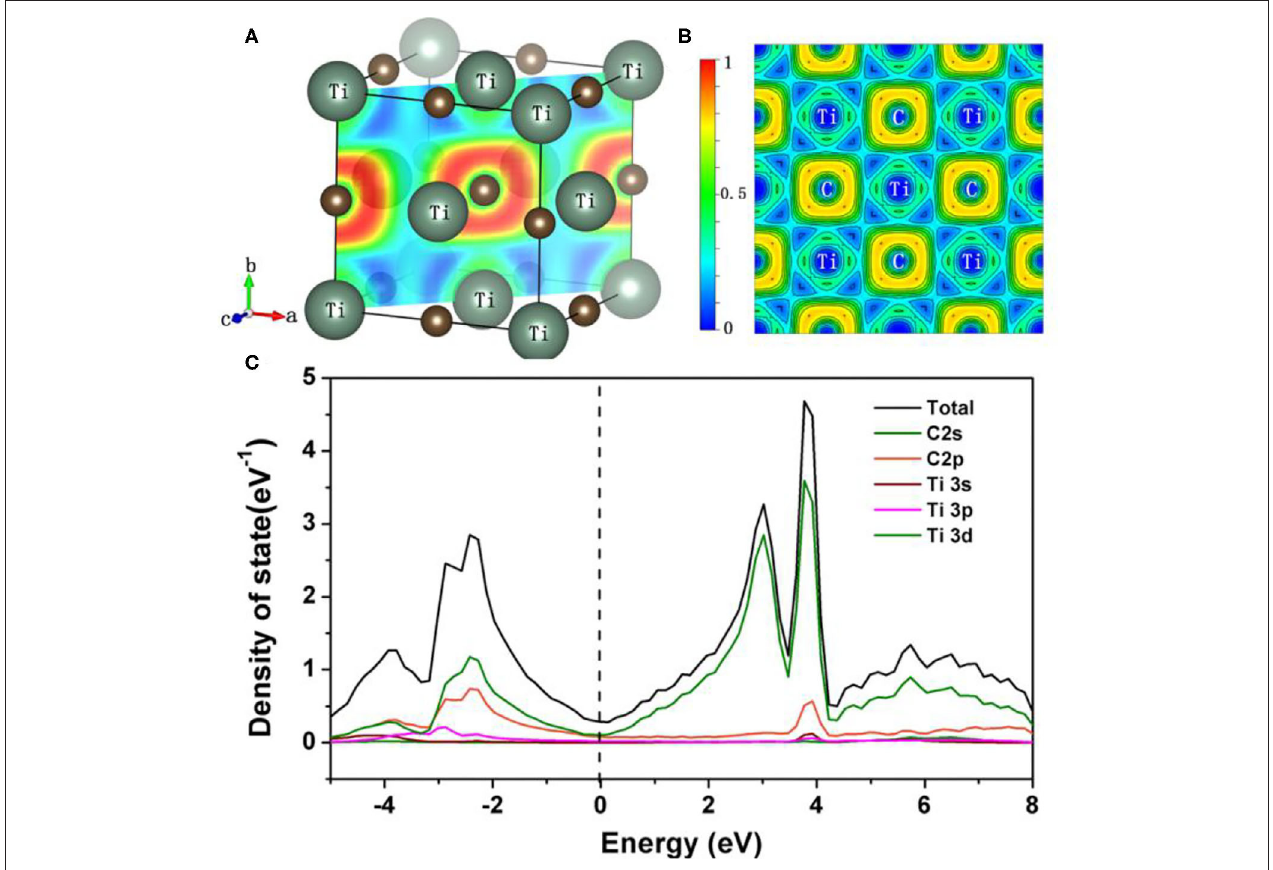
FIGURE 4 | (A,B) ELF and CDD slices of (110) plane of TiC. (C) Calculated density of states of TiC. The Fermi energy level (E F ) is shown by a vertical dashed line.